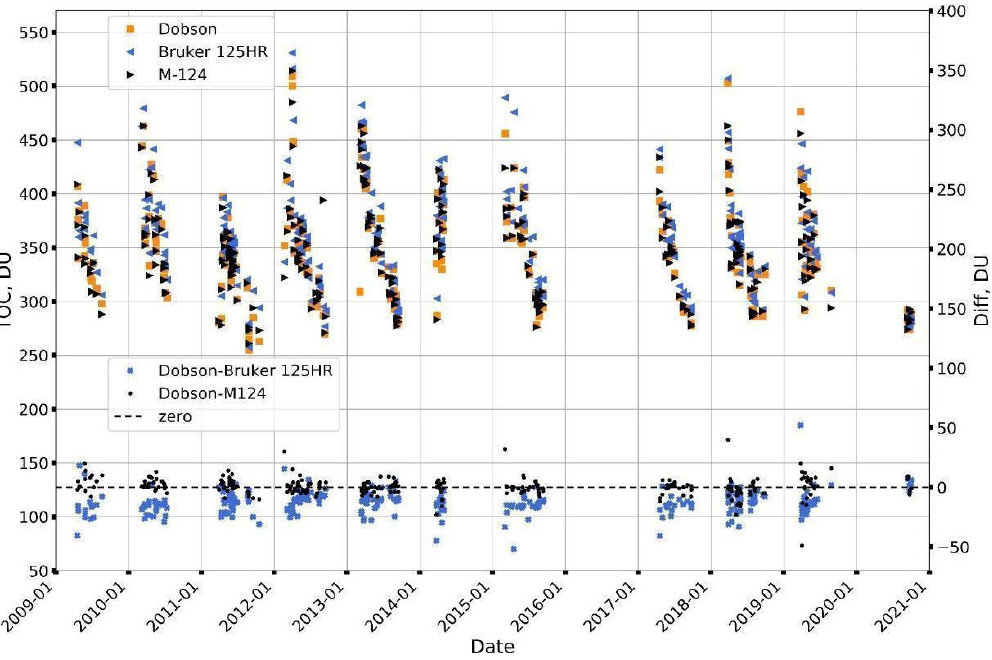
Figure 2. Time series of daily mean TOCs near St. Petersburg in the 2009–2020 period according to the Dobson, M-124 and Bruker 125 HR ground-based measurements (left scale) and their differences (right scale).